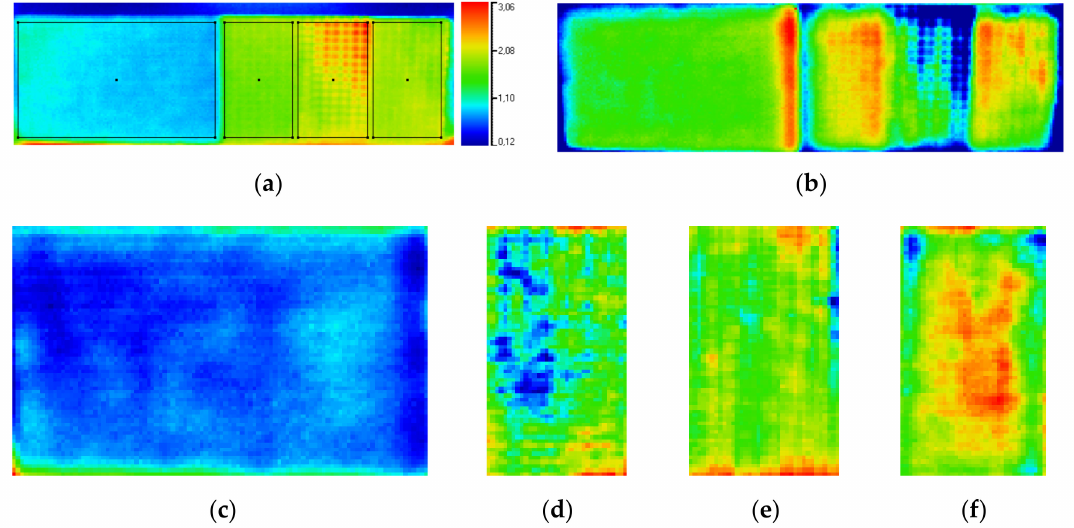
Figure 18. PCA-processing results. ( a ) Raw thermogram at 7 s; ( b ) 1st principal component; ( c ) area 1 (Figure 1a), 2nd component; ( d ) area 2 (Figure 1a), 3rd component; ( e ) area 3 (Figure 1a), 3rd component; ( f ) area 4 (Figure 1a), 3rd